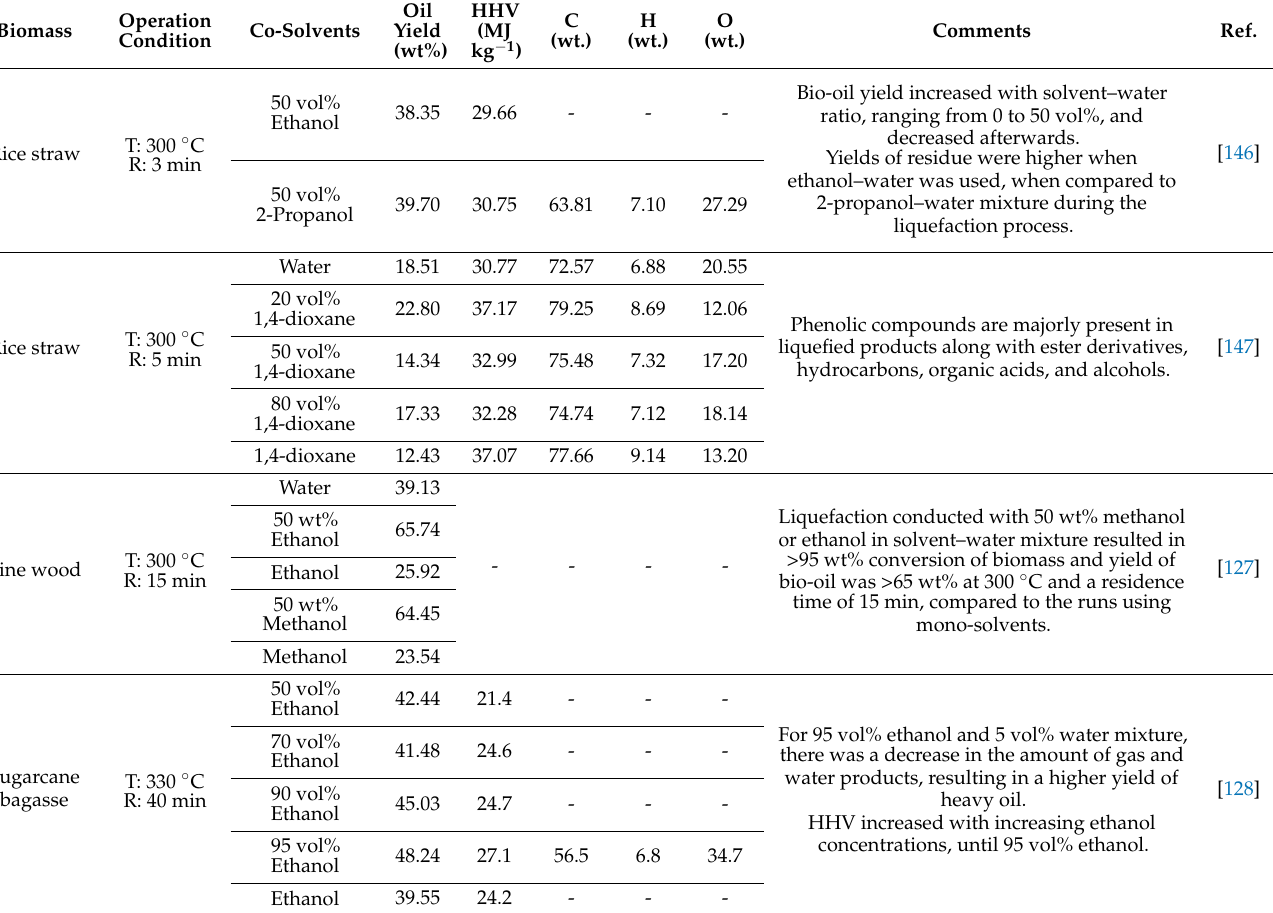
Table 11. Major solvents and co-solvents used in the HTL